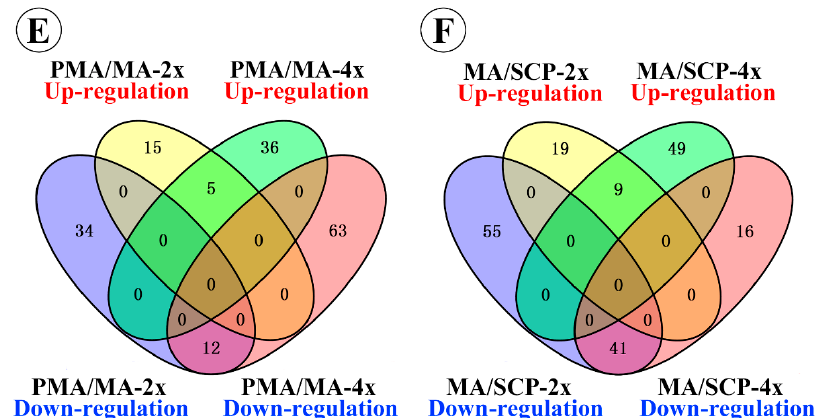
Figure 2. Classification of miRNAs during pollen development: ( A , B ) the total number of miRNAs detected during different pollen development stages of Taichung65-2x ( A ) and Taichung65-4x ( B ); ( C , D ) Venn analysis of miRNAs expressed in Taichung65-2x ( C ) and Taichung65-4x during pollen development ( D ); and ( E , F ) specifically up- and down-regulated miRNAs during each adjacent stage of pollen development in Taichung65-2x and Taichung65-4x. PMA, MA and SCP represent pre-meiotic interphase, meiosis and single microspore stage, respectively. “4x” and “2x” represent the autotetraploid and diploid rice, respectively.